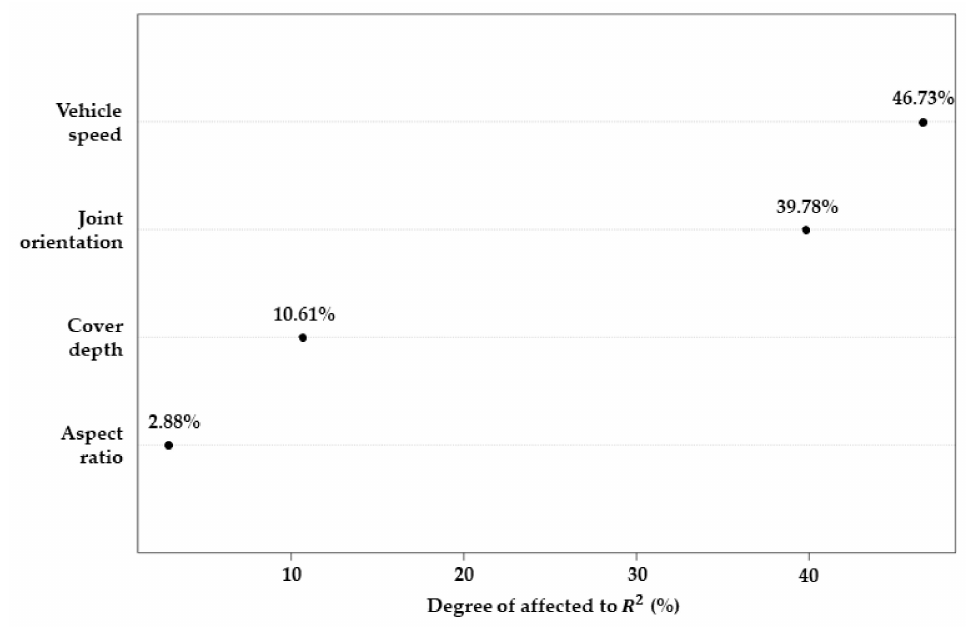
Figure 7. Relative importance of explanatory